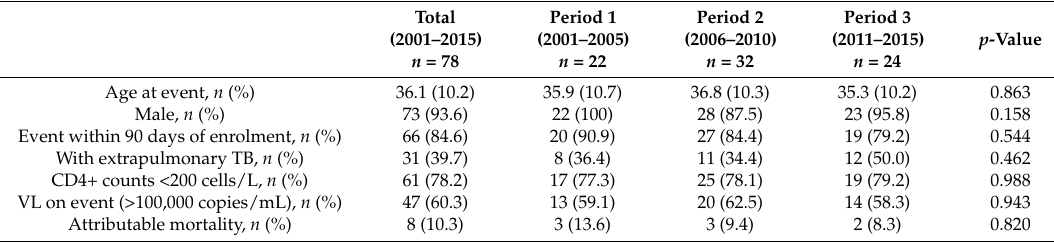
Table 5. Demographics, laboratory findings, and proportion of extrapulmonary tuberculosis (TB) among 78 patients with MTB